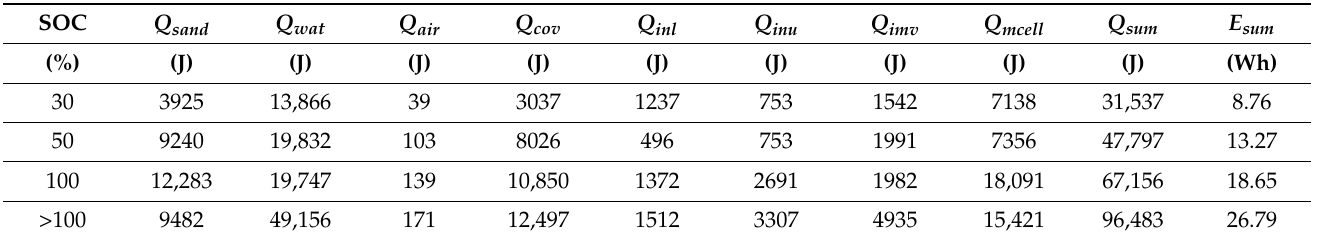
Table 3. Calculation results of the energy released during the thermal escape process. Q i expressed in (J), total energy in